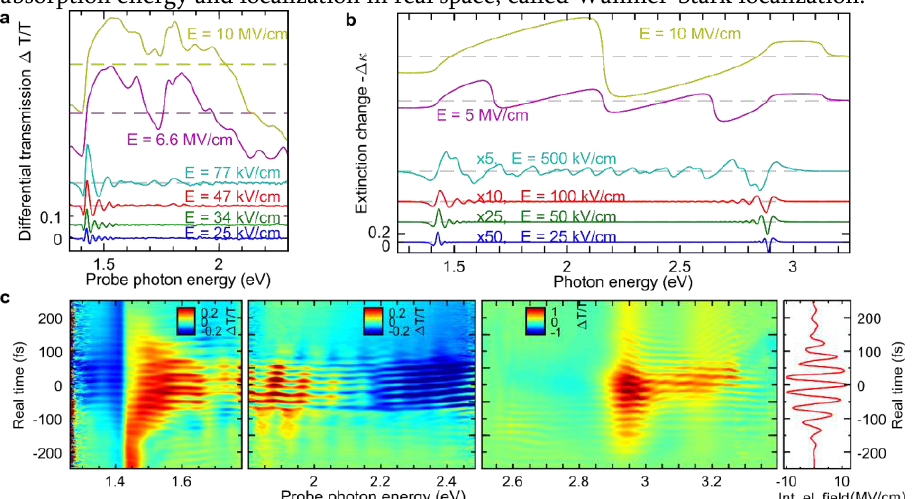
Fig. 2. (a) Differential transmission measurements of 400 nm bulk GaAs. For bias fields below 100 kV/cm transient Franz-Keldysh oscillations are visible. At extreme fields reaching 10 MV/cm inside the material a strong blueshift of the fundamental absorption from 1.42 to 2.1 eV is observed. (b) Calculation of extinction coefficient change based on cosine-shaped band structure that reproduce the essential features of the experimental data. (c) colormap of the differential transmission measurements as a function of delay time and probe photon energy from NIR to UV. Far right panel: electric field inside GaAs over